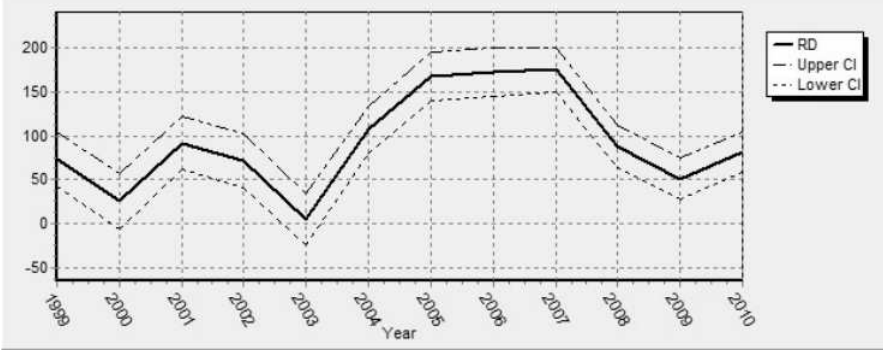
Figure 5. Trends of rate difference of age-standardised PYLL rates among men in Świętokrzyskie, years 1999-2010